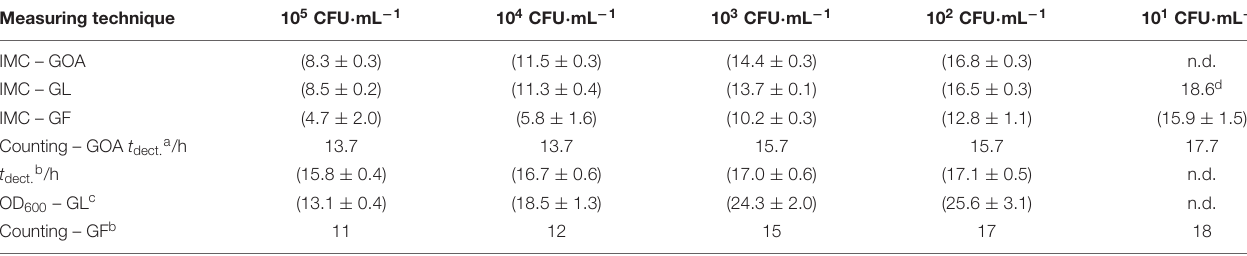
TABLE 2 | Comparison of the detection times (in h) determined by conventional techniques and IMC measurements. Measuring technique